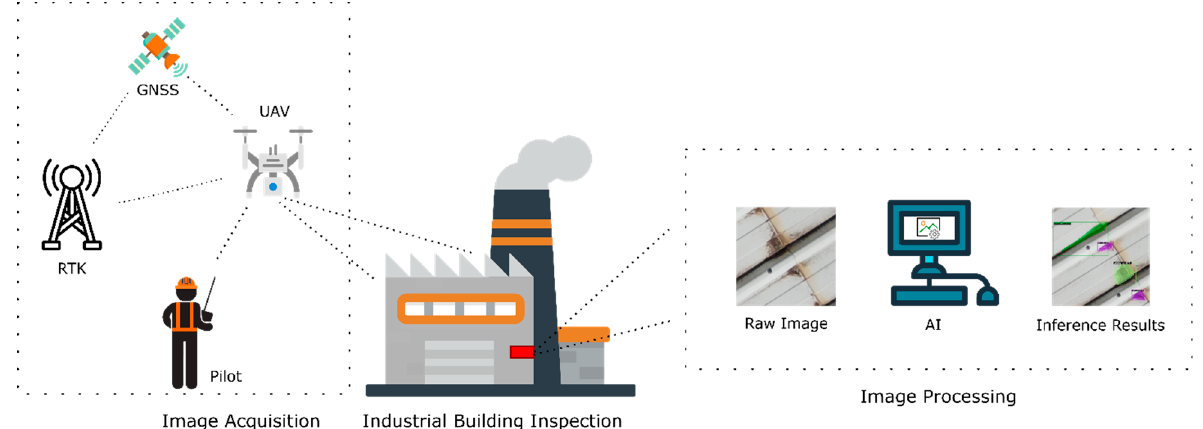
Figure 1. Overview of the methodology for automatic detection of corrosion.